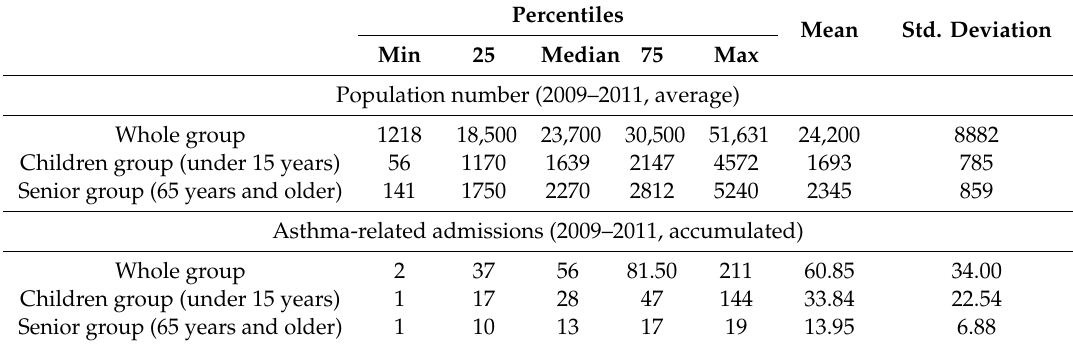
Table 1. Basic Statistics of the Population and Asthma-related Admissions per dong in Seoul. Percentiles Mean Std. Deviation Min 25 Median 75 Max